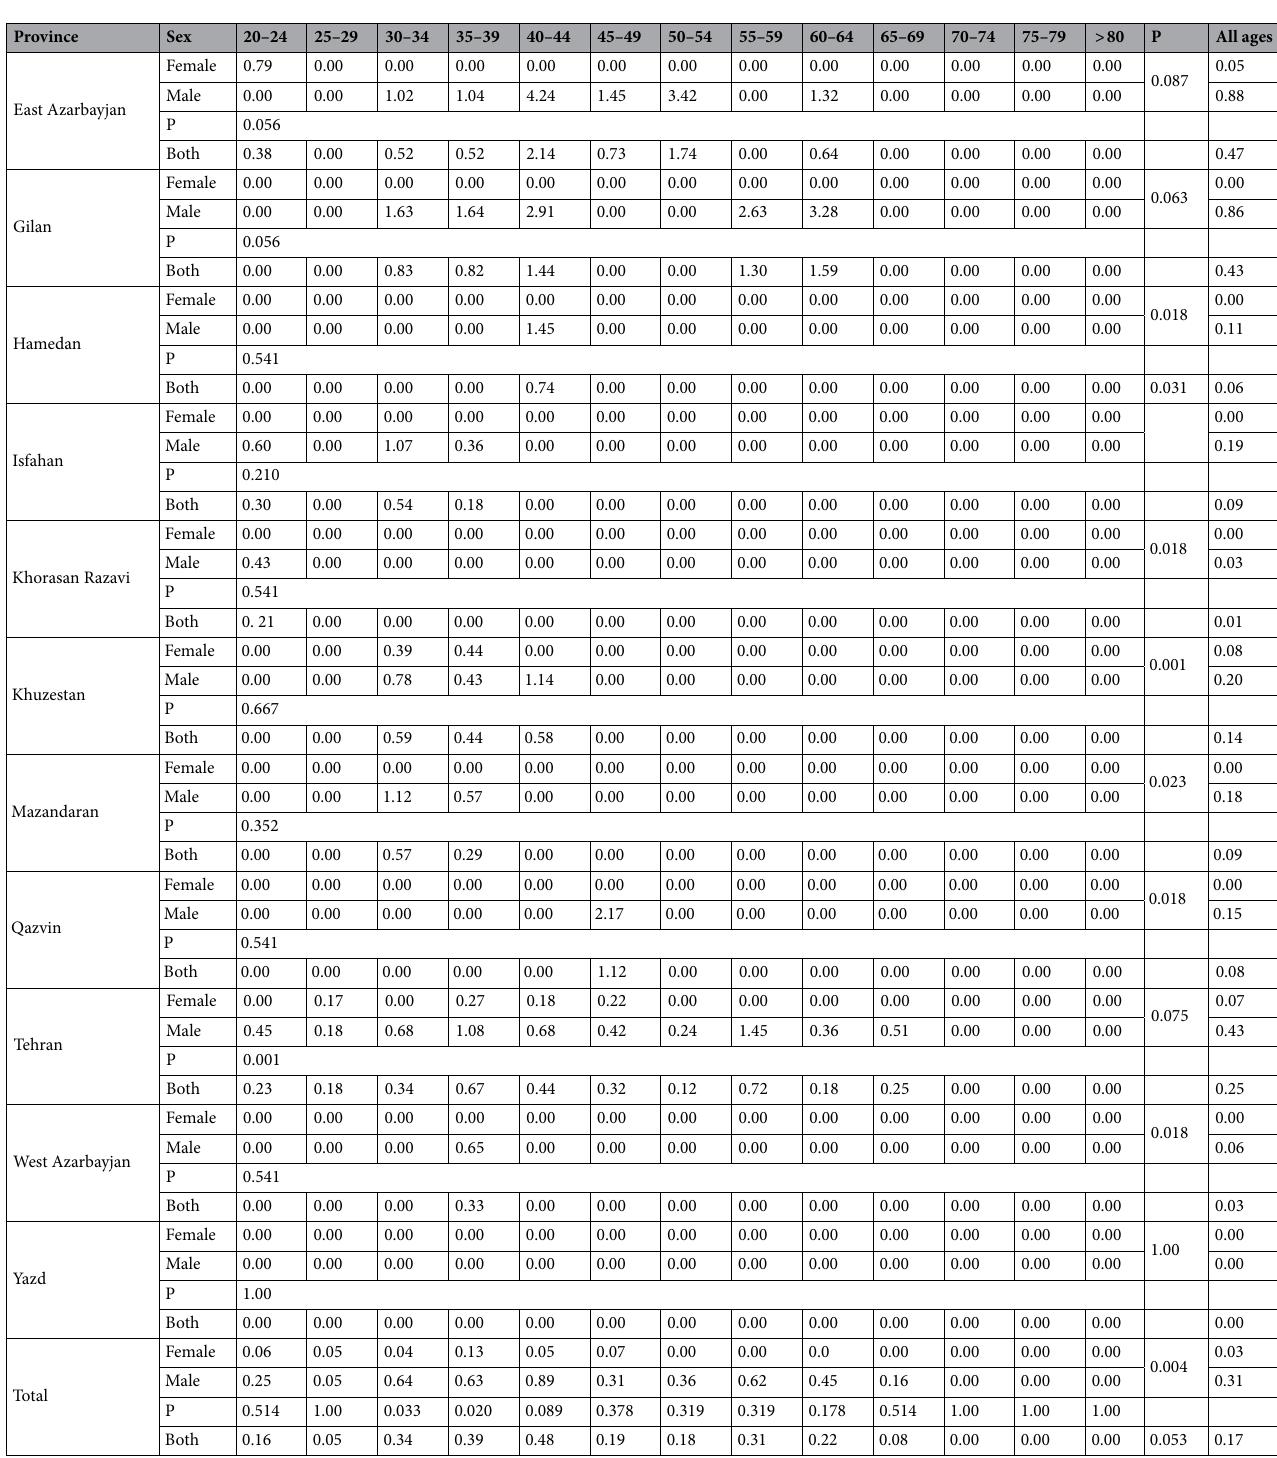
Table 2. Deaths per 100,000 population in different age/sex groups in 11